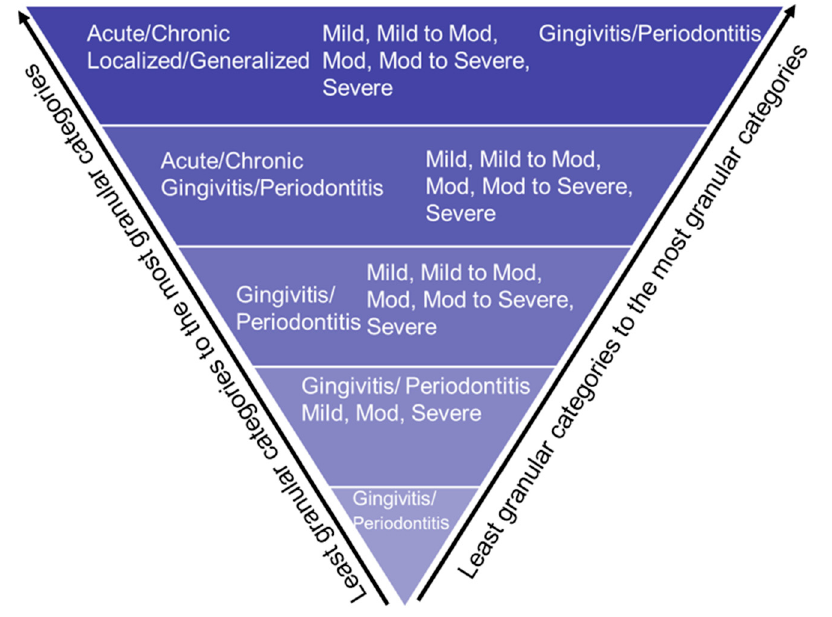
Figure 2. Bottom-up approach to extract PD based on disease type, disease severity, disease location, and disease extension.